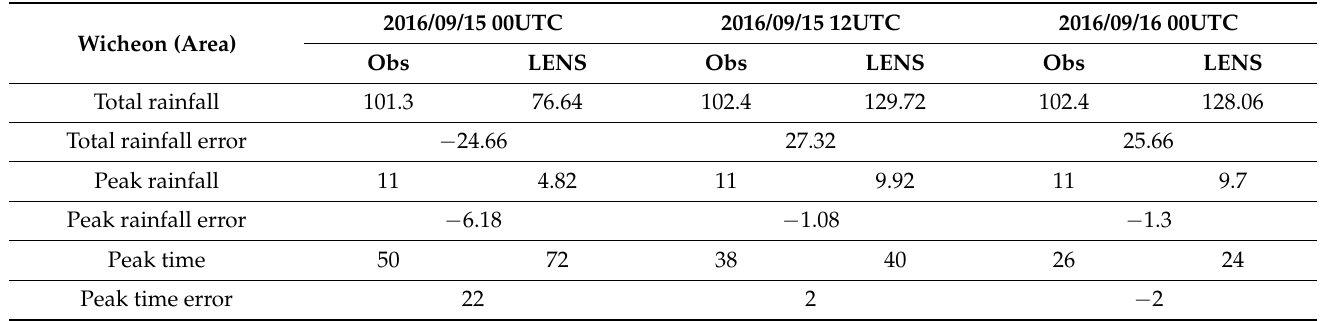
Table 6. LENS area data from 2016/09/15 00UTC to 2016/09/16